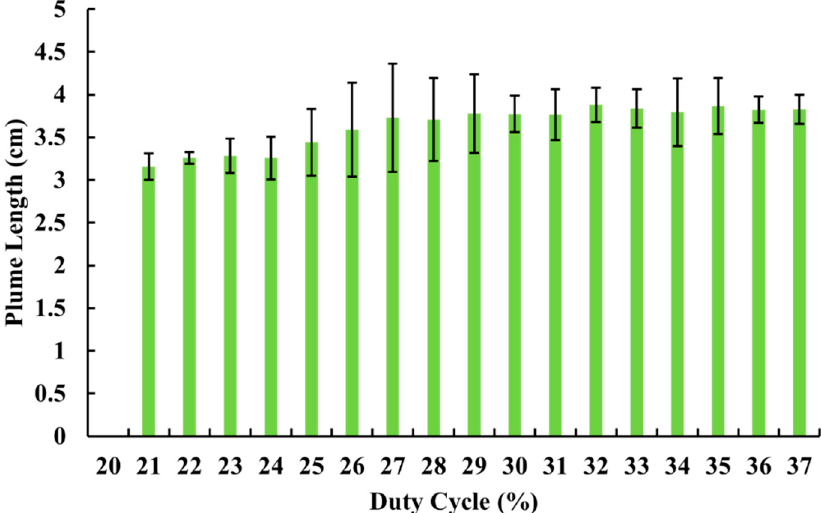
Figure 6. Duty cycle’s effect on plume length. The duty cycle varied between 20 and 37%, while all other parameters were held constant. Gas flow was 4.2 lpm, and frequency was 16 kHz. Electrode spacing was 9.8 cm. All experiments were repeated three times. The results are shown as the mean ± standard deviation (error bar).